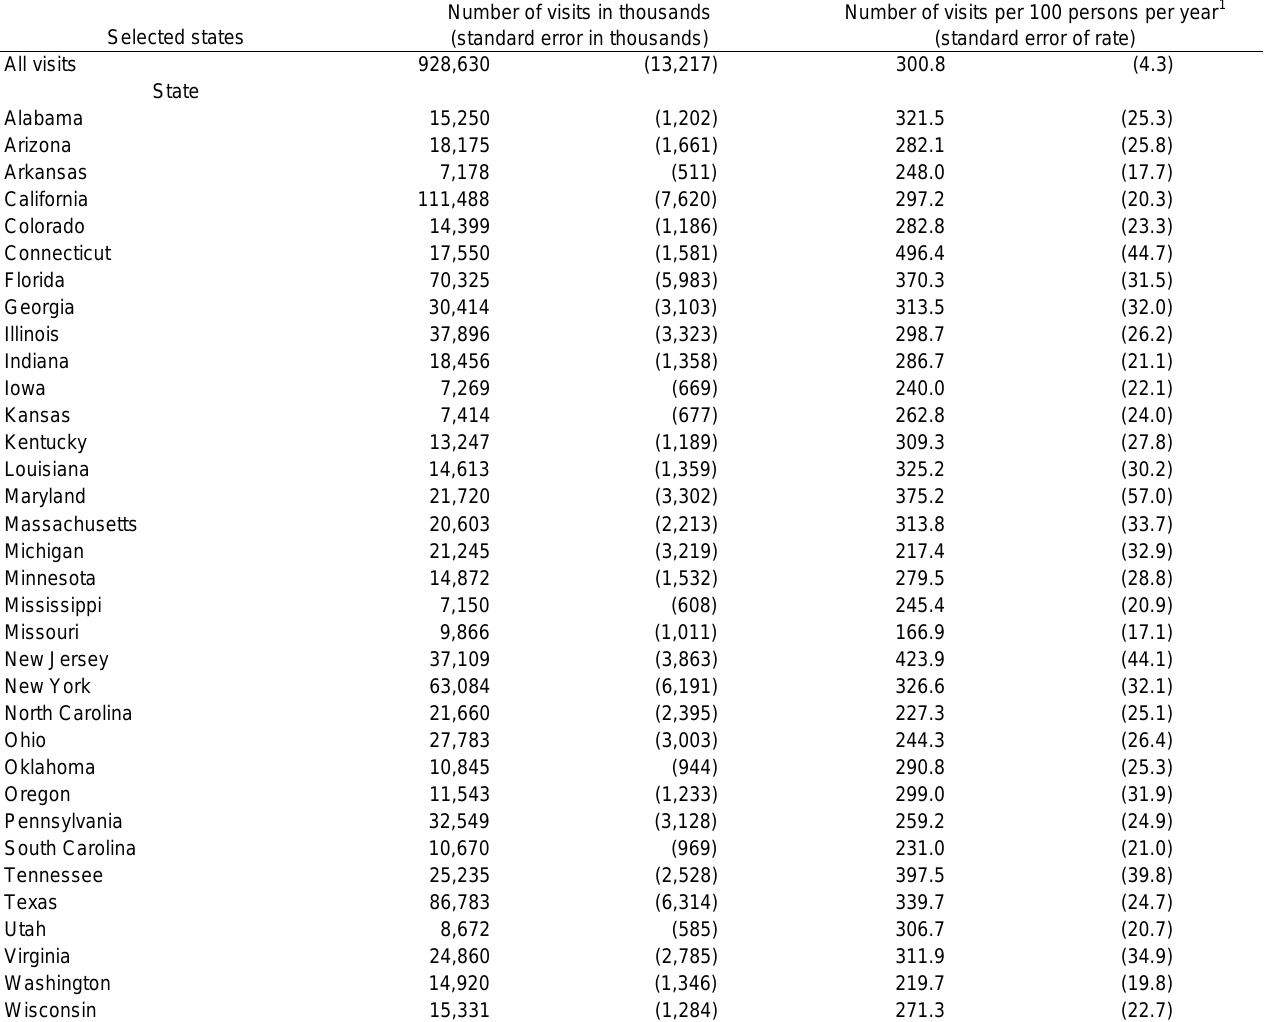
Table 2. Office visits by selected states: United States,